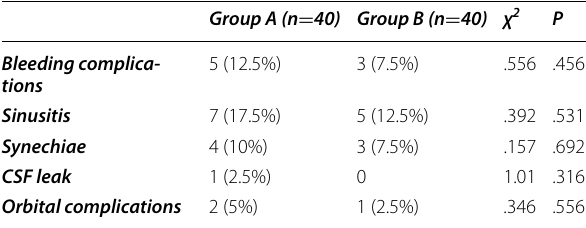
Table 4 Postoperative complications between the two studied groups